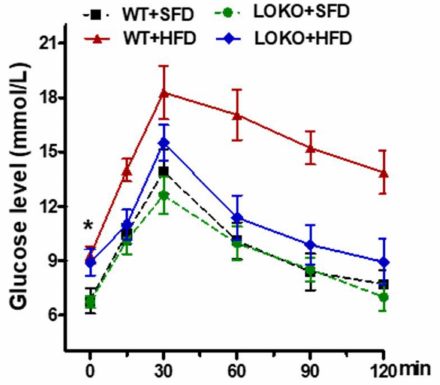
Figure 6. HFD WT instead of LOKO mice have reduced glucose tolerance. Blood glucose levels were tested at 30 min intervals following an intro-peritoneal glucose injection. WT HFD mice showed a higher fasting glucose level before glucose injection (* p < 0.05), along with a slower rate of glucose clearance compared with other groups, including LOKO HFD